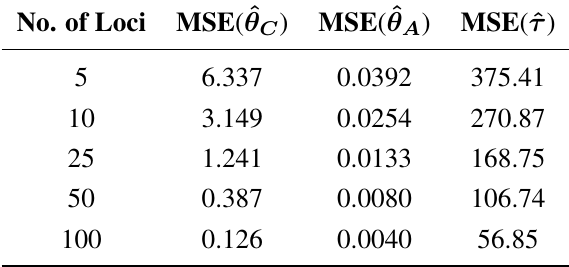
Table 4. Mean Squared Error (MSE) of the parameters estimated for a growing